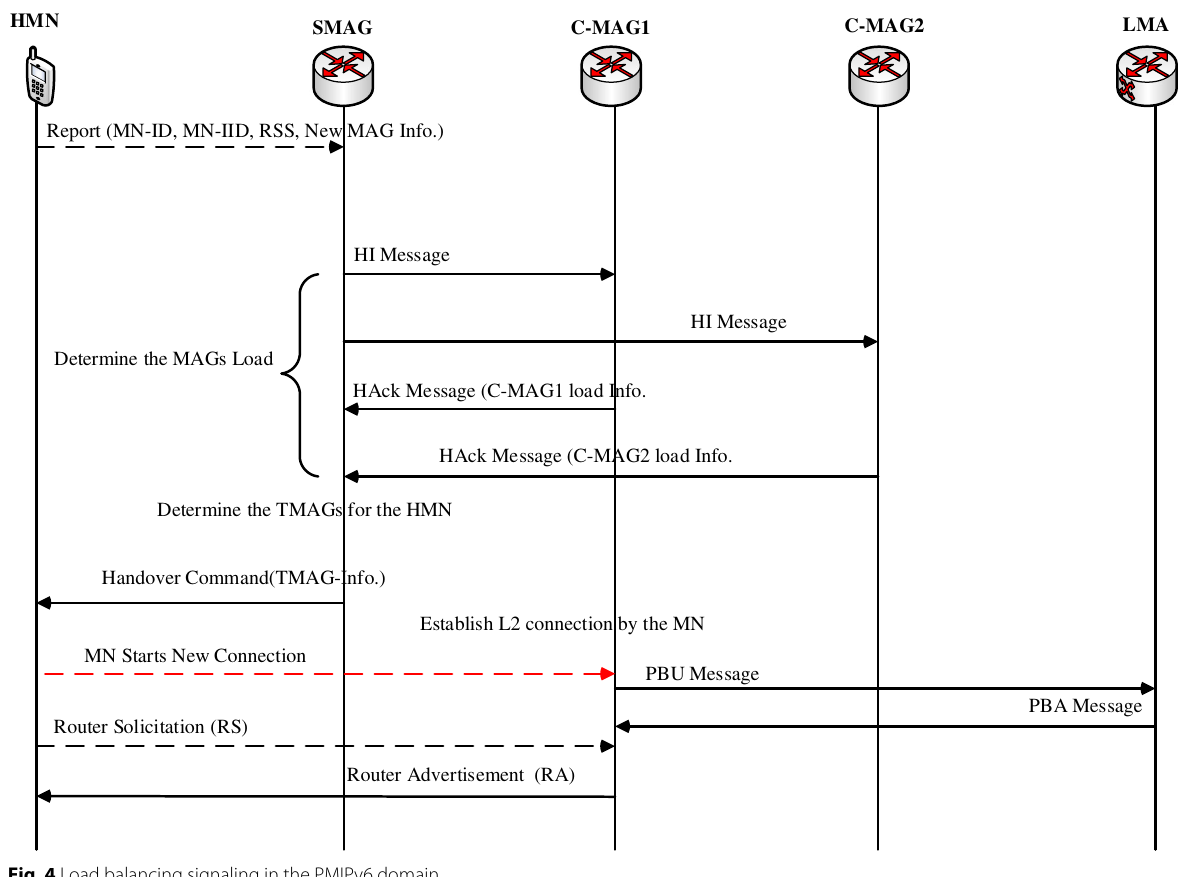
Fig. 4 Load balancing signaling in the PMIPv6 domain